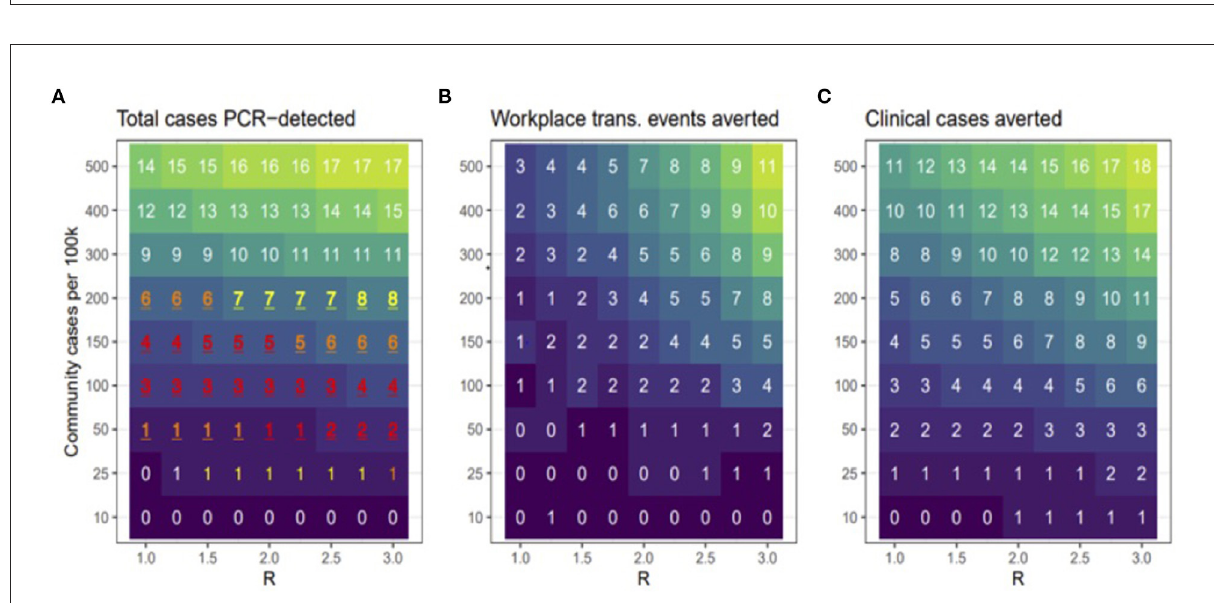
FIGURE2 Model scenarios. (A) shows the total number of cases that were PCR-detected (clinical or non-clinical). Red, orange, and yellow text shows scenarios in which the 95% prediction interval overlapped the observed number (3) of PCR-positive cases in the cohort, with redder text indicating better correspondence between modeled and observed results. (B) shows how many workplace transmission events were avoided relative to the no testing baseline and (C) shows the total number of clinical cases averted during bi-weekly testing relative to no testing baseline. Across all panels, lower to higher numbers are shaded in darker to lighter colors,